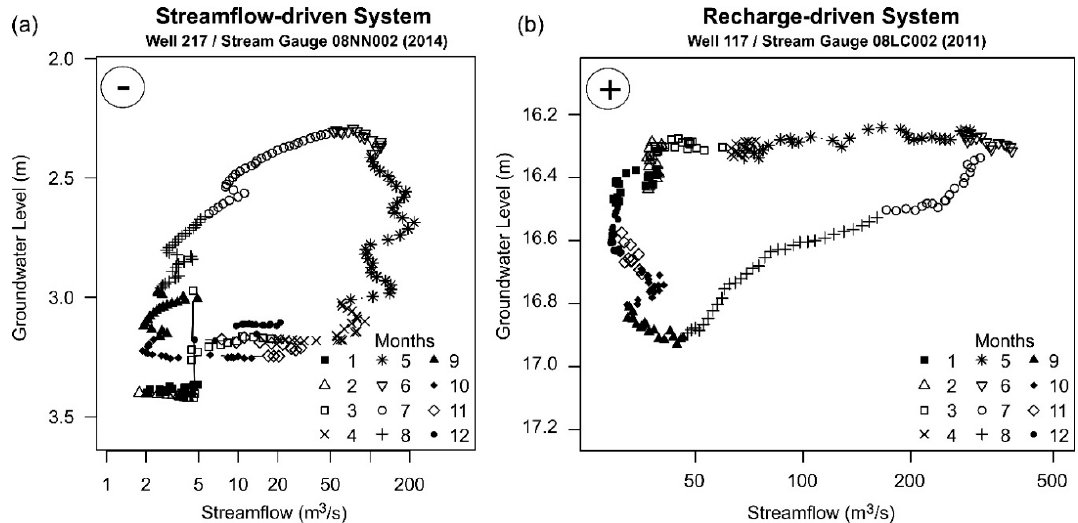
Figure 2. Representative hysteresis plots for ( a ) a streamflow-driven system characterized by a negative or counter-clockwise loop, and ( b ) a recharge-driven system characterized by a positive or clockwise hysteresis loop.